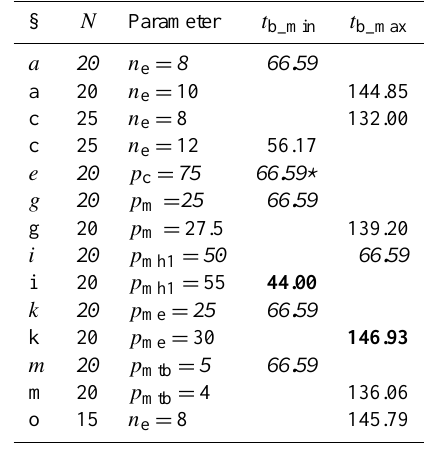
Table 11. Minimum ( (cid:49)z cr_min ) and maximum ( (cid:49)z cr_max ) safety margins of the average kernel (only experiments with (cid:56) max = 1 are considered). In the first column, the letters refer to Fig. 19. In bold, the best and worst experiments. An asterisk marks the experiment e , in which (cid:56) max was reached only for p c = 75. In italics, the com- binations of parameters of the benchmark experiment (cf. Table